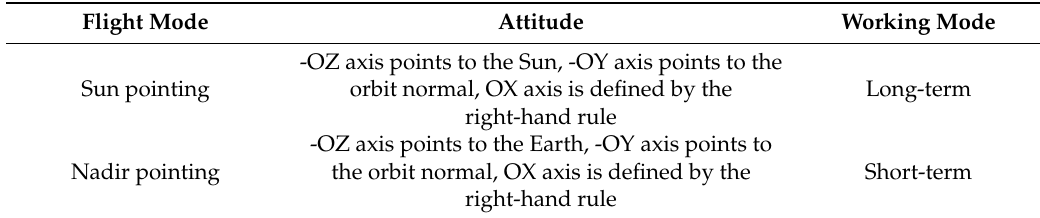
Table 2. Flight mode and attitude of the satellite orbit.